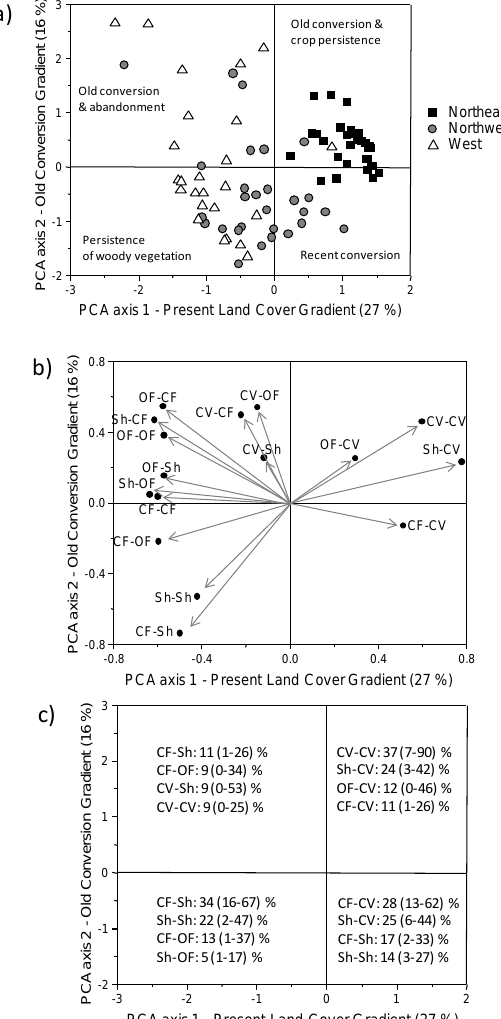
Figure 2. ( a ) Ordination of circles in the plane defined by the first two Principal Component Analysis (PCA) axes. Different symbols represent the three sectors of the study area used to stratify sampling; ( b ) Contribution of the variables (classes of land cover changes between 1979 and 2010) to the two axes of the PCA ordination; ( c ) Average (and range between brackets) of the four major land cover changes between 1979 and 2010 for circles positioned in each PCA quadrant. For b and c, the first two letters indicate the land cover in 1979 and the second pair indicates the land cover in 2010: cultural vegetation (CV), shrubland (Sh), closed forest (CF), open forest (OF). In short, axis 1 represents the trends in present land cover, while axis 2 may be interpreted as an old conversion gradient. Thus, according to the position along both axes, circular samples could be